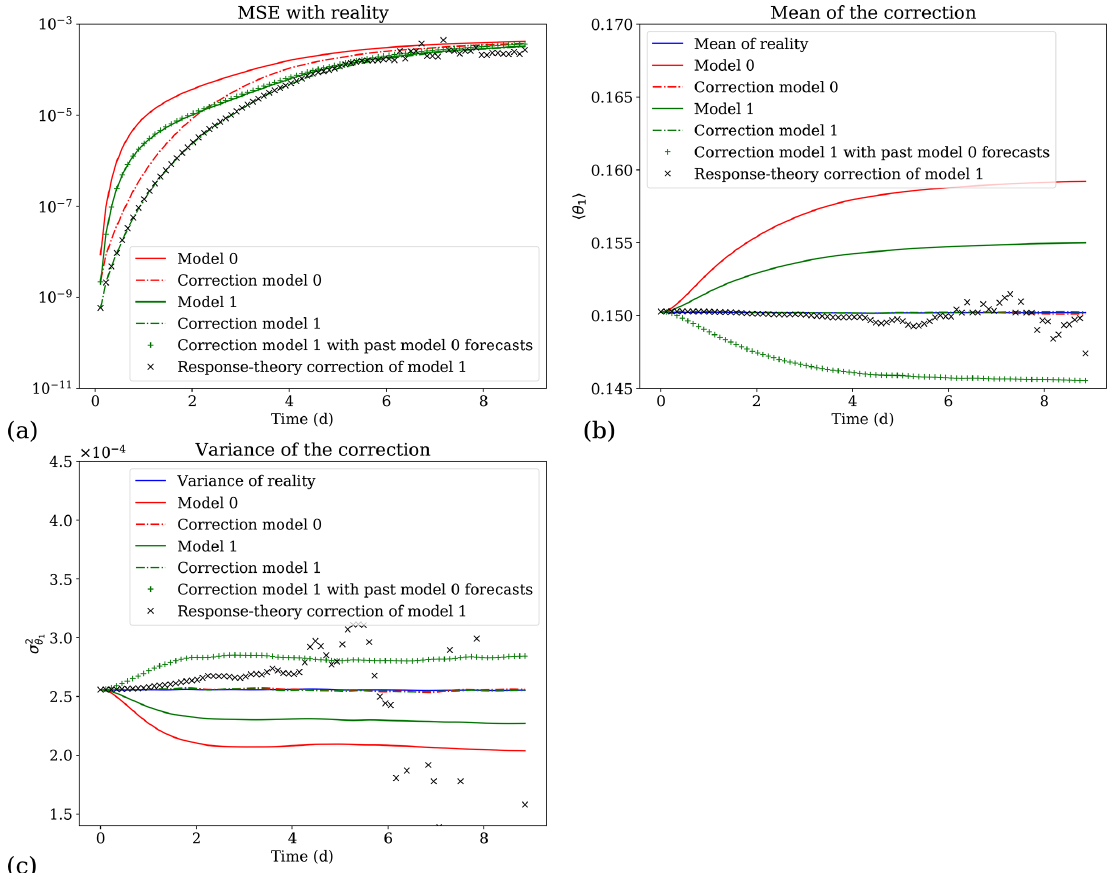
Figure 9. Performance of the corrections on the variable θ 1 for the experiment with the modification of the friction coefficient. (a) Mean square error (MSE) evolution between the different forecasts and their correction and reality. (b) Mean of the different trajectories (reality, model 0 and model 1) and corrected forecasts. (c) Variance of the different trajectories and corrected